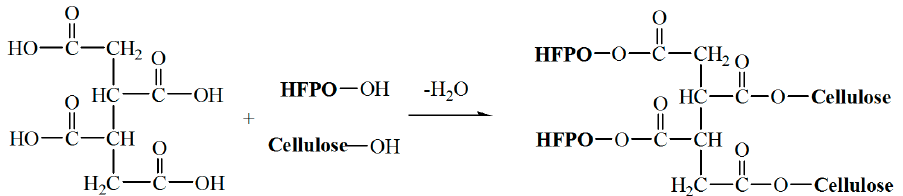
Table 3. The phosphorus and calcium concentrations of the Nomex ® /cotton blend fabric treated with 3% BTCA and HFPO at different concentration and cured at 170 °C for 3 min.